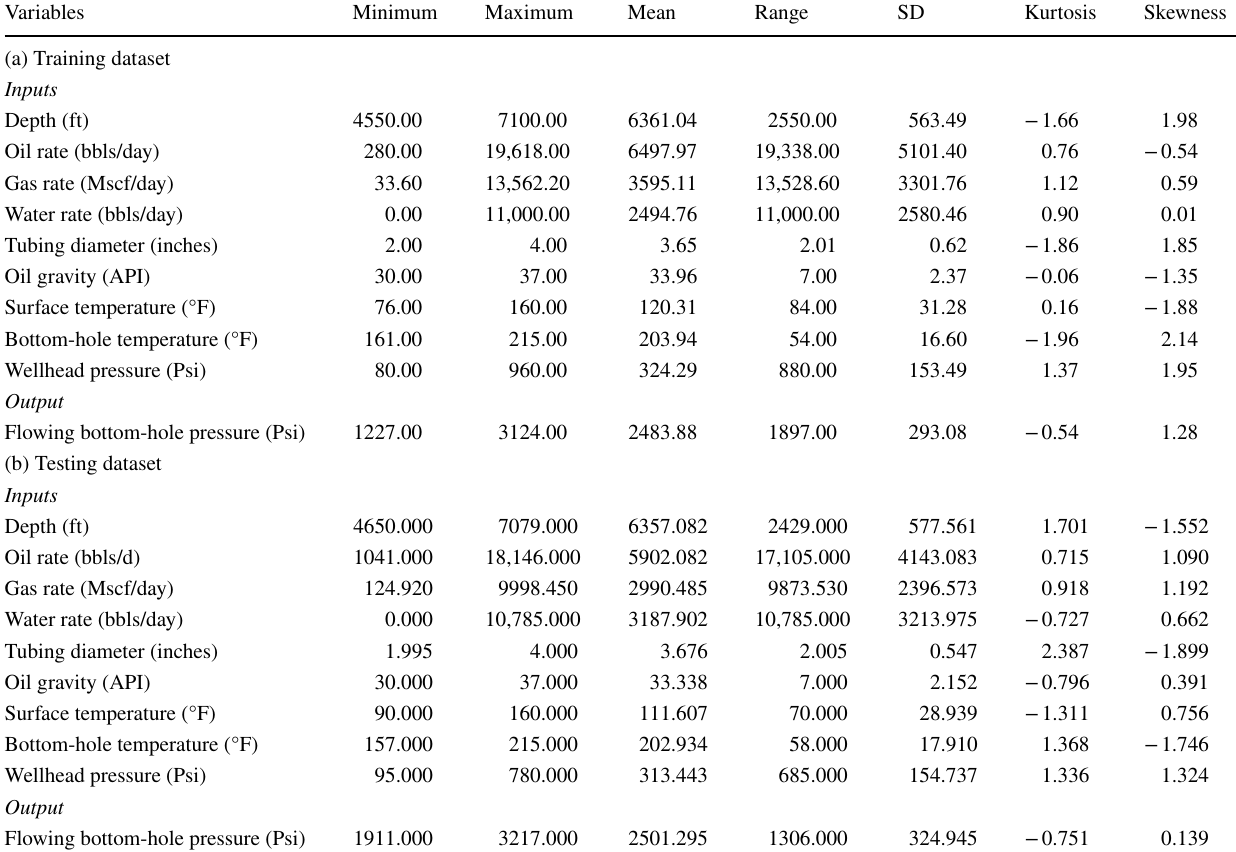
Table 2 Statistical description of (a) training dataset and (b) testing dataset